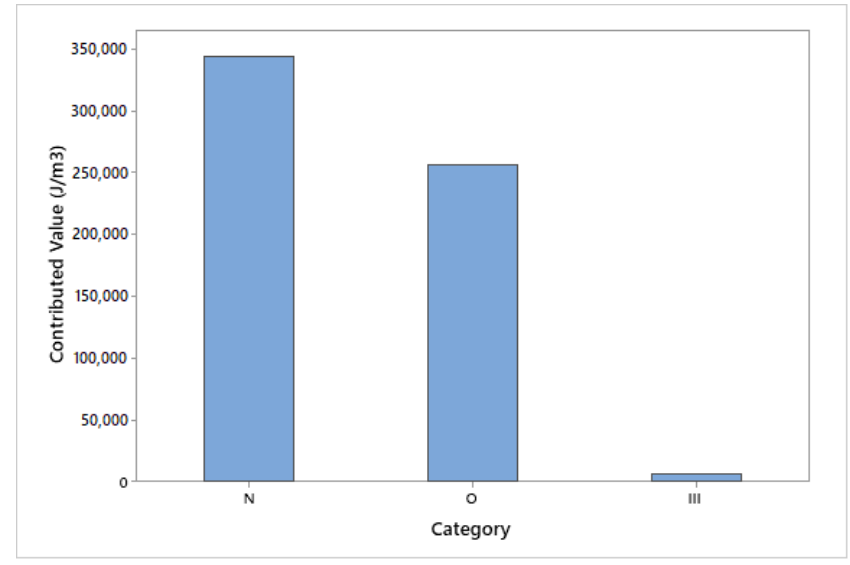
Figure 15. Contribution of sample categories to the chi-squared value.